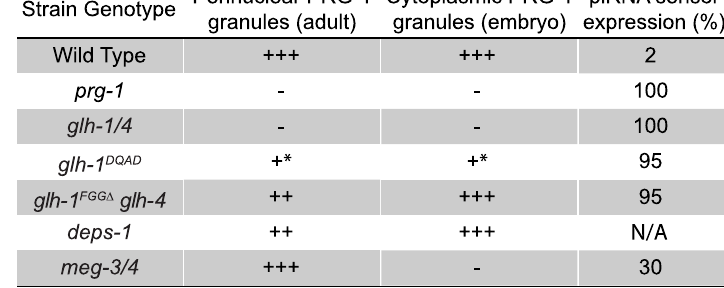
effectongranulepropertiesisprovidedinSupplementaryFig.2a. b GFPexpression in the piRNA reporter and the ability to form perinuclear or cytoplasmic PRG-1 granules in the indicated